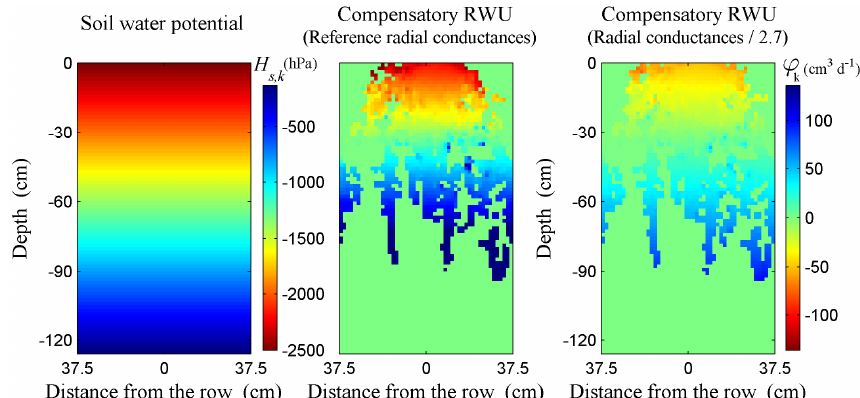
Fig. 6. Illustration of the relation between the compensatory RWU ϕ , the soil water potential H s and the root hydraulic properties. Figure 6. Illustration of the relation between the compensatory RWU φ , the soil water 3 potential H s and the root hydraulic properties. 4